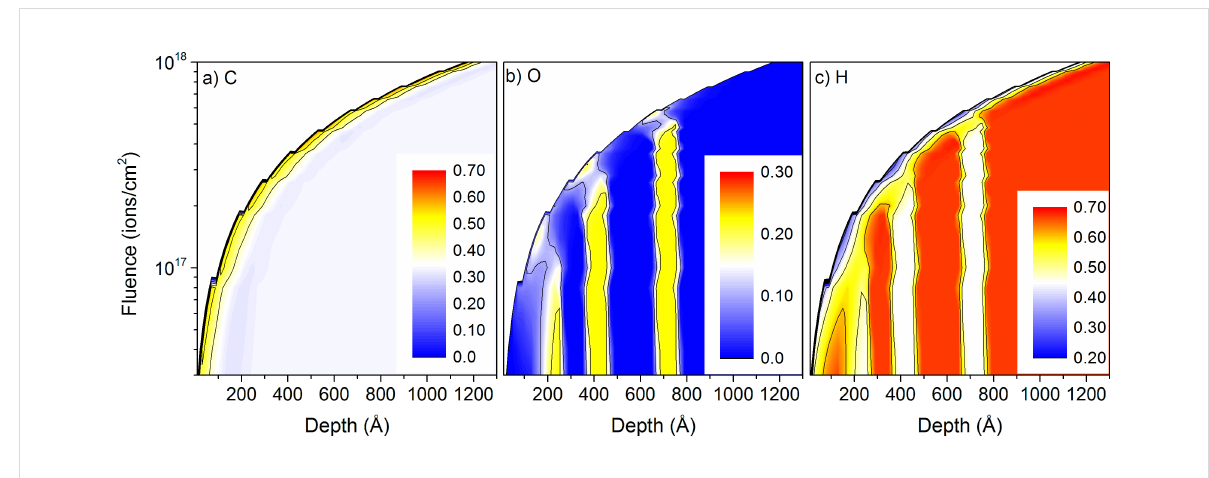
Figure 8: Sample composition as a function of depth and primary ion fluence for 1 keV Ne + irradiation of sample #3 with the thin-layer configuration: a) for carbon, b) for oxygen, and c) for hydrogen. The colour scales are different for the three species.